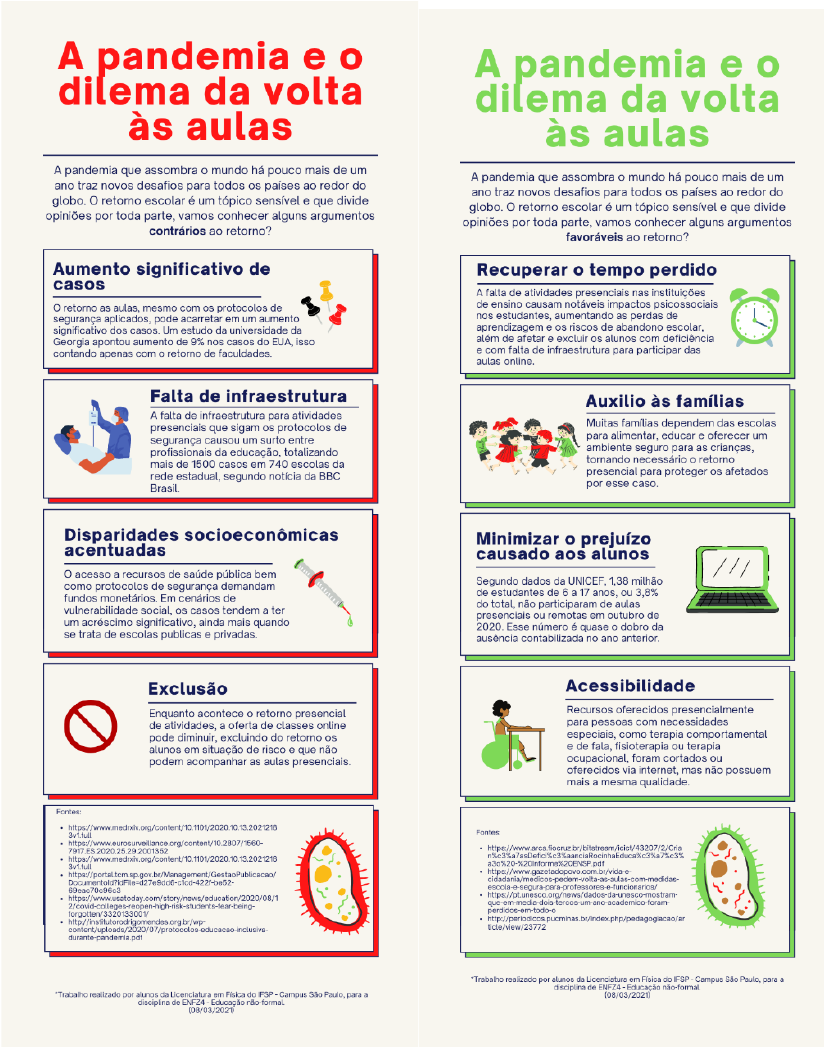
Figure 3: Infographic produced by students (text in Portuguese) 6